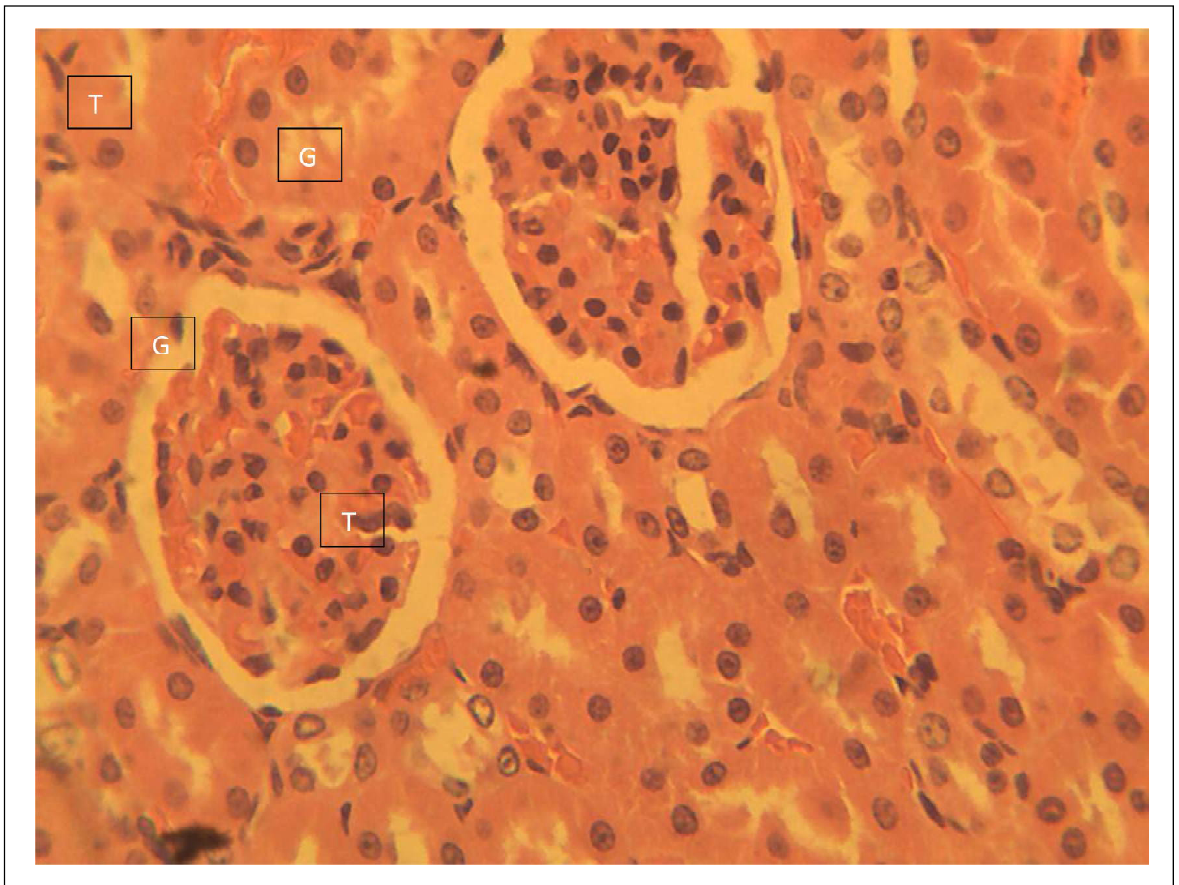
Plate 10: Male kidney of the group exposed to 800 mg/kg of methanol